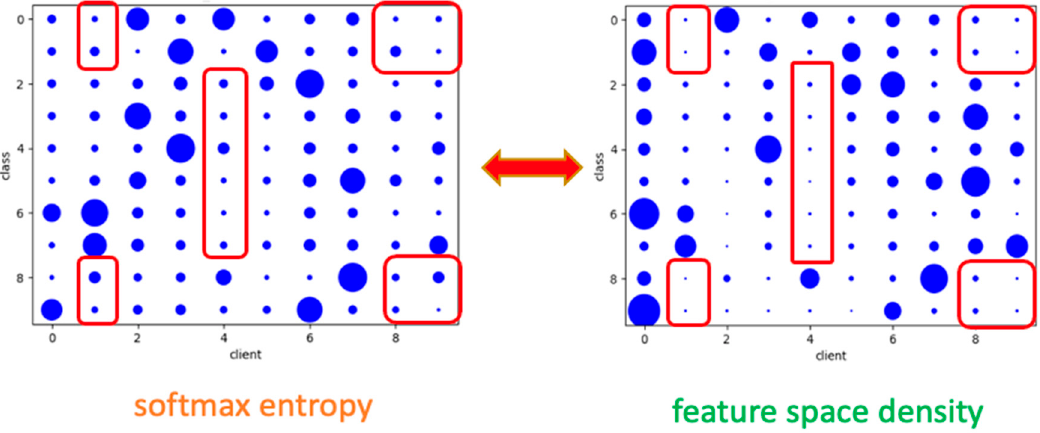
Figure 12. The sparsity comparison between the top-1 SoftMax outputs’ entropy and the top-1 feature space density’s entropy.